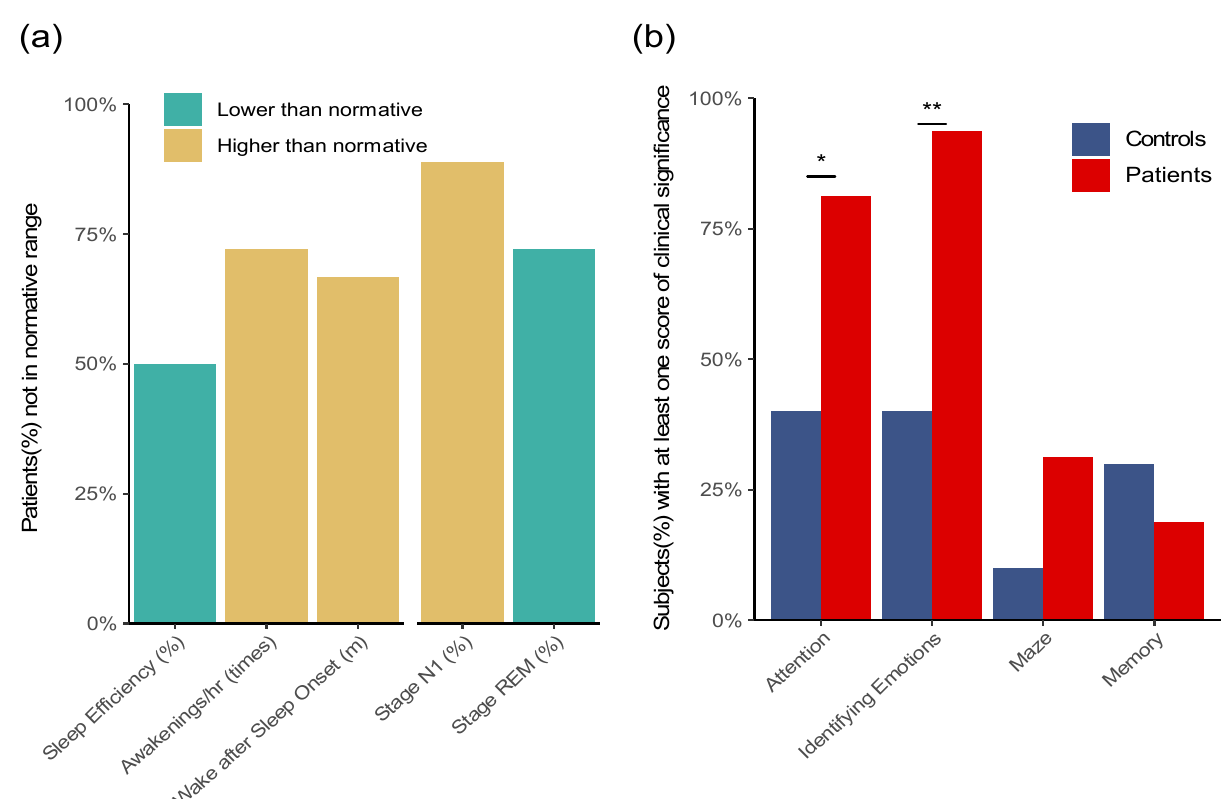
Figure 3. Sleep Monitoring and Cognitive Tests of the Severe ME/CFS Patients. ( a ) Five parameters in the overnight monitoring by Sleep Profiler where the values in ≥ 50% of the patients were consistently out of the normal ranges. These include lower sleep efficiency, more frequent awakenings per hour (>30 s), longer time of wake after sleep onset, a higher percentage of Stage N1, and a lower percentage of Stage R (REM). ( b ) Comparison between the patients and controls in each of the four sections of cognitive tests. The Y-axis represents the percentage of subjects that were identified as severe/deficit impairment. The patients compared with the controls showed significantly more problems in identifying emotions (94% of the patients vs. 40% of the controls, p = 0.005), as well as more attention problems (81% of the patients vs. 40% of the controls, p =